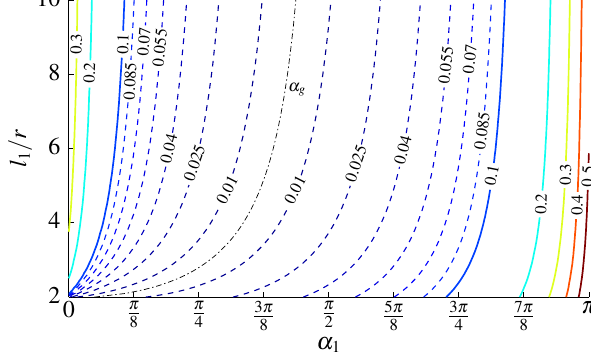
Figure 7. Maximum error in the interval α 0 ≤ α ≤ α 2 as a function of α 1 and l 1 / r .